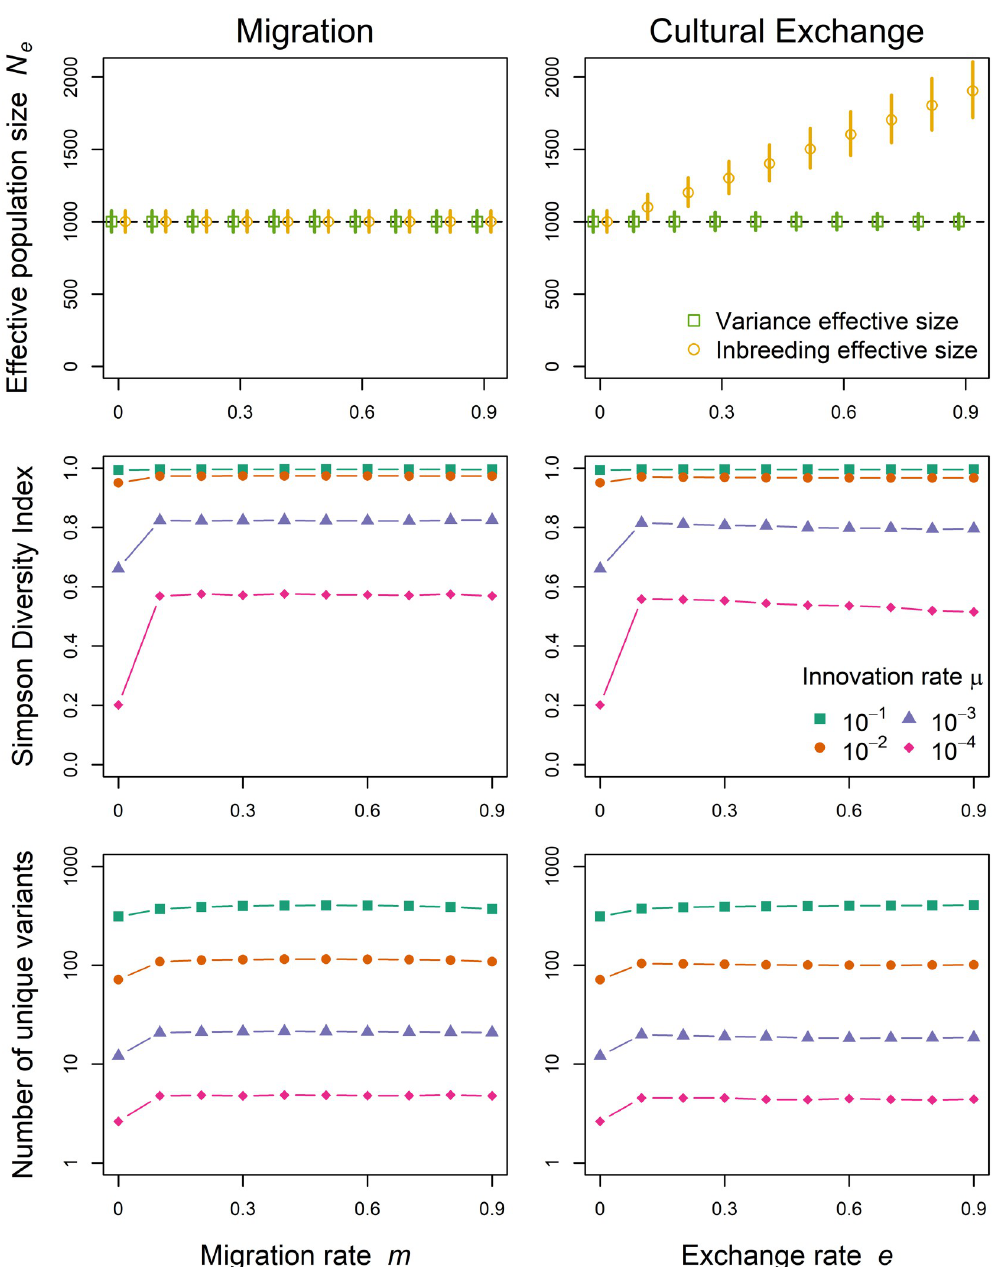
Fig 4. Population connectedness. Variance (green squares) and inbreeding (yellow circles) effective population sizes (including 90% PIs; top), Simpson diversity (center) and mean numbers of unique variants (on log scale; bottom) for different migration rates m on the left and cultural exchange rates e on the right. We need to differentiate between effective size formulations because population sizes might differ between parental and offspring generations. Results come from 1000 independent stochastic simulations with census population size N =